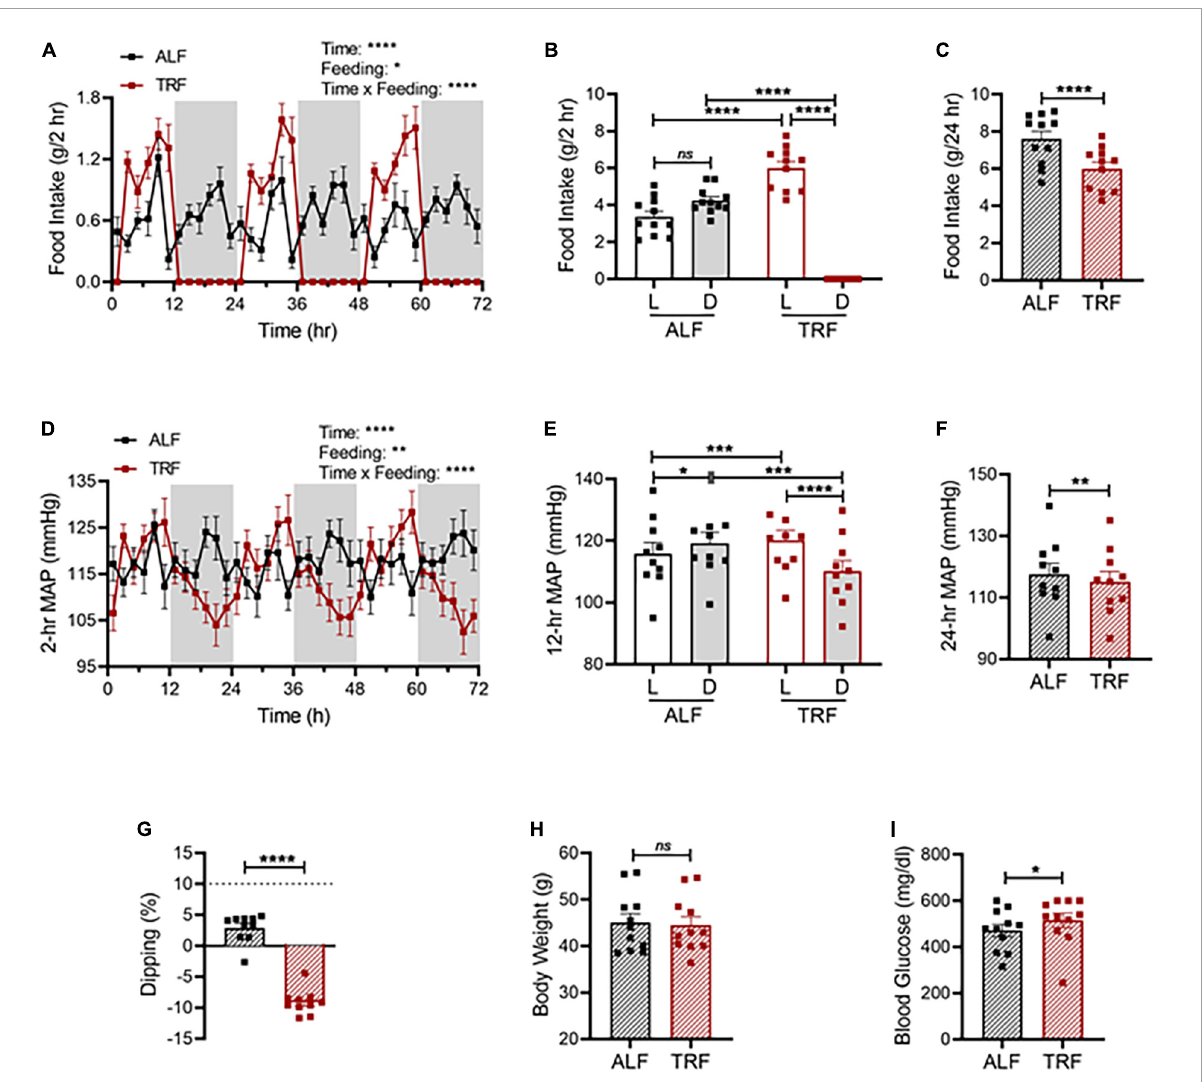
FIGURE6 Light-phase TRF worsens BP rhythm and blood glucose in db/db mice. (A–C) Accumulated food intake in 2-h (A) , 12-h (B) , and 24-h (C) intervals in 21-week-old male db/db mice ( N = 10) over 3 days of ALF and during the last 3 days of TRF. (D–F) Average MAP in 2-h (D) , 12-h (E) , and 24-h (F) intervals over 3 days with ALF or during the last 3 days of TRF. (G) Non-dipping MAP (less than 10%) with ALF and reverse dipping with light-phase TRF. (H,I) Body weight (H) and blood glucose (I) were determined at ZT1 under ALF and after 7 days of TRF. Data were expressed as the mean ± SEM and analyzed by repeated two-way ANOVA with matching conditions between light vs. dark phase and between ALF vs. light-phase TRF with Tucky’s post hoc analysis (A,B,D,E) or paired t -test (C,F,G–I) . * P < 0.05; ** P < 0.01; **** P < 0.0001; ns, not